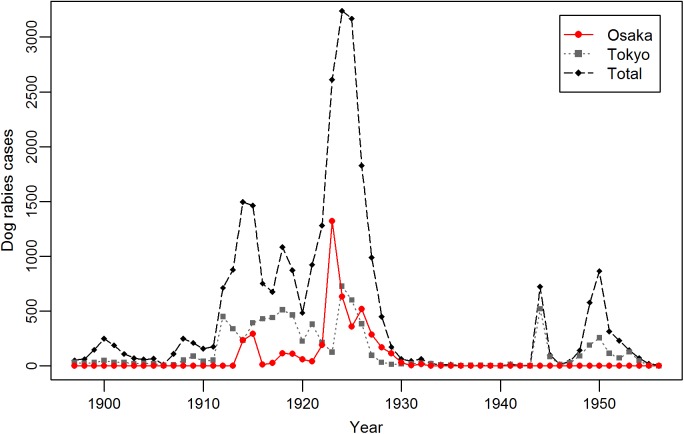
Temporal dynamics of dog rabies cases in Osaka and Tokyo Prefectures, and total numbers in Japan between 1897 and 1956, the year of elimination.